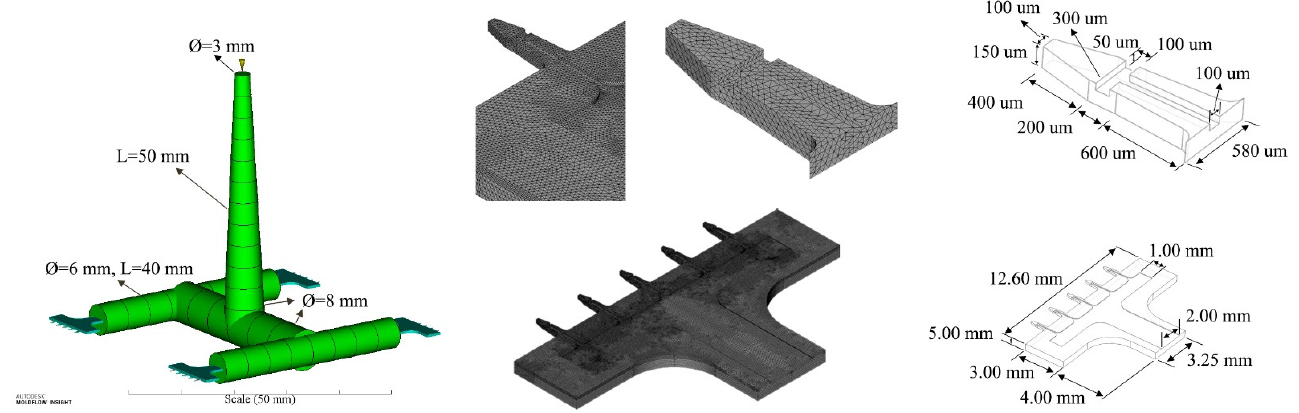
Figure 1. Finite element model, and the main dimensions of the microneedle array